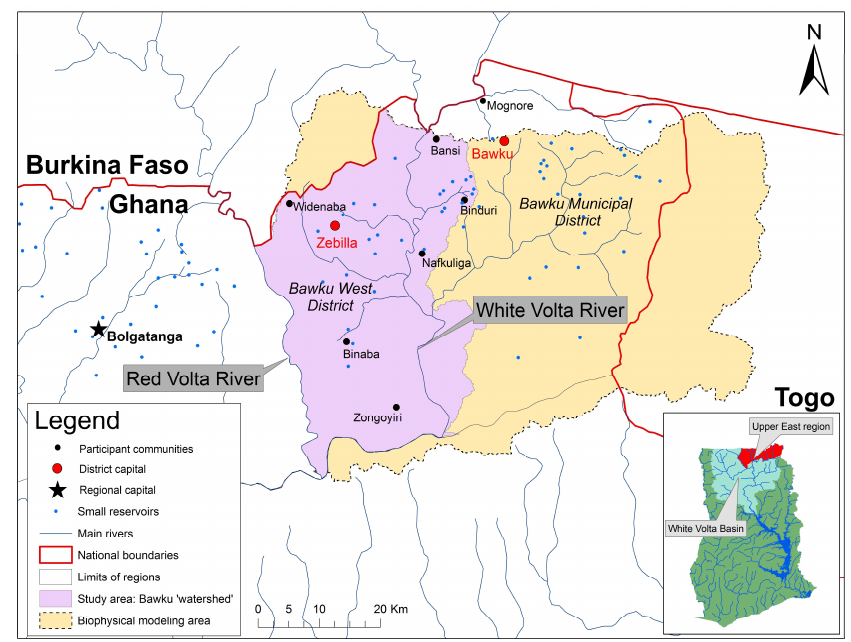
Figure 1. Main features of the study area.